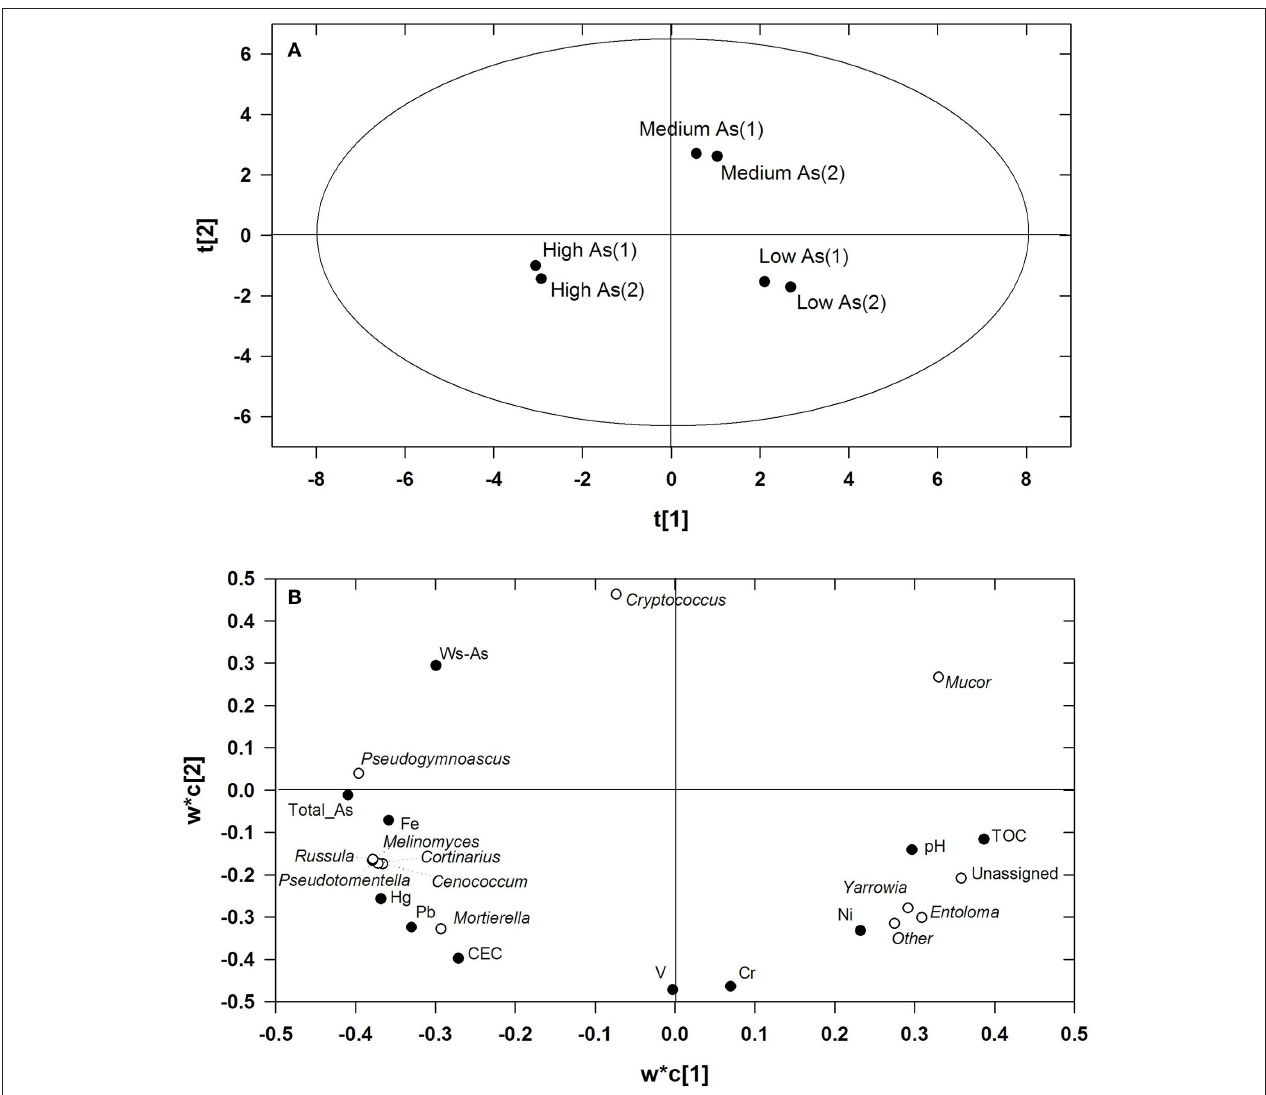
FIGURE 2 | Scores (A) and loadings plot (B) of the PLS model relating the relative frequencies of most abundant fungal genera to the descriptors of the High As, Medium As, and Low As soils. The fraction of variance of all the response variable explained by the first and second latent PLS component amounted to 68.8 and 29.9%,